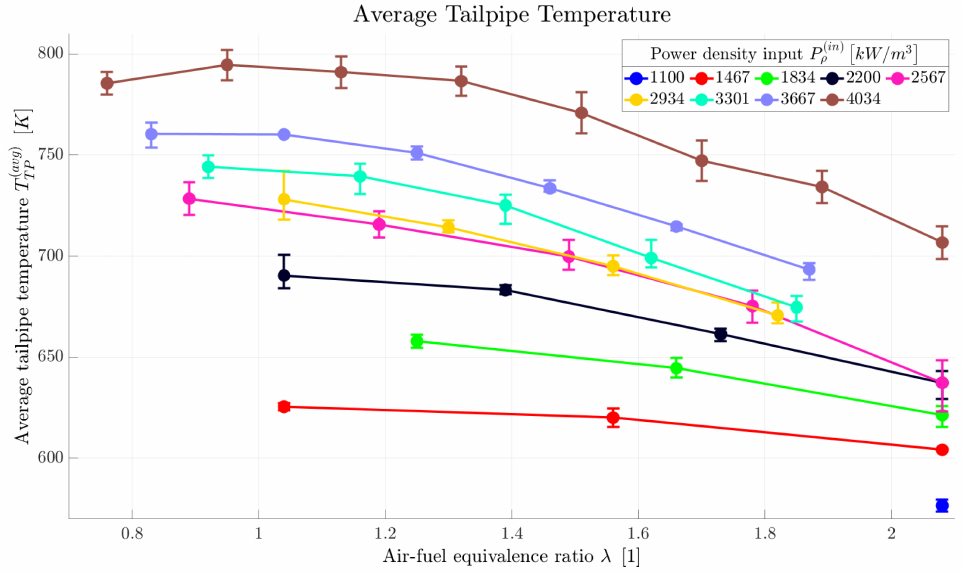
Figure 15. Average tailpipe temperature displayed relative to air–fuel equivalence ratio for several power density input